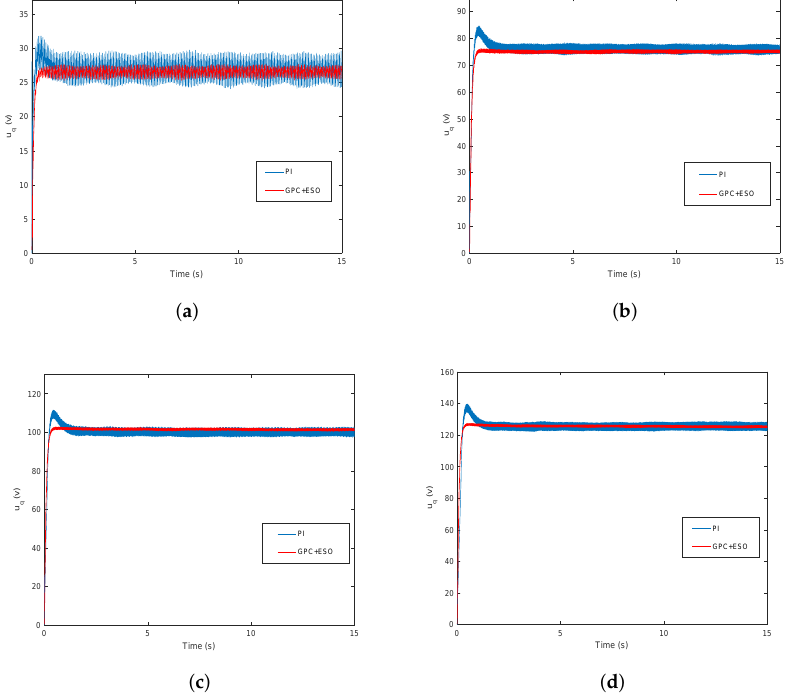
Figure 8. Experimental response curves of u q under the GPC+ESO and PI method. ( a ) n = 200 r/min; ( b ) n = 600 r/min; ( c ) n = 800 r/min; and ( d ) n = 1000